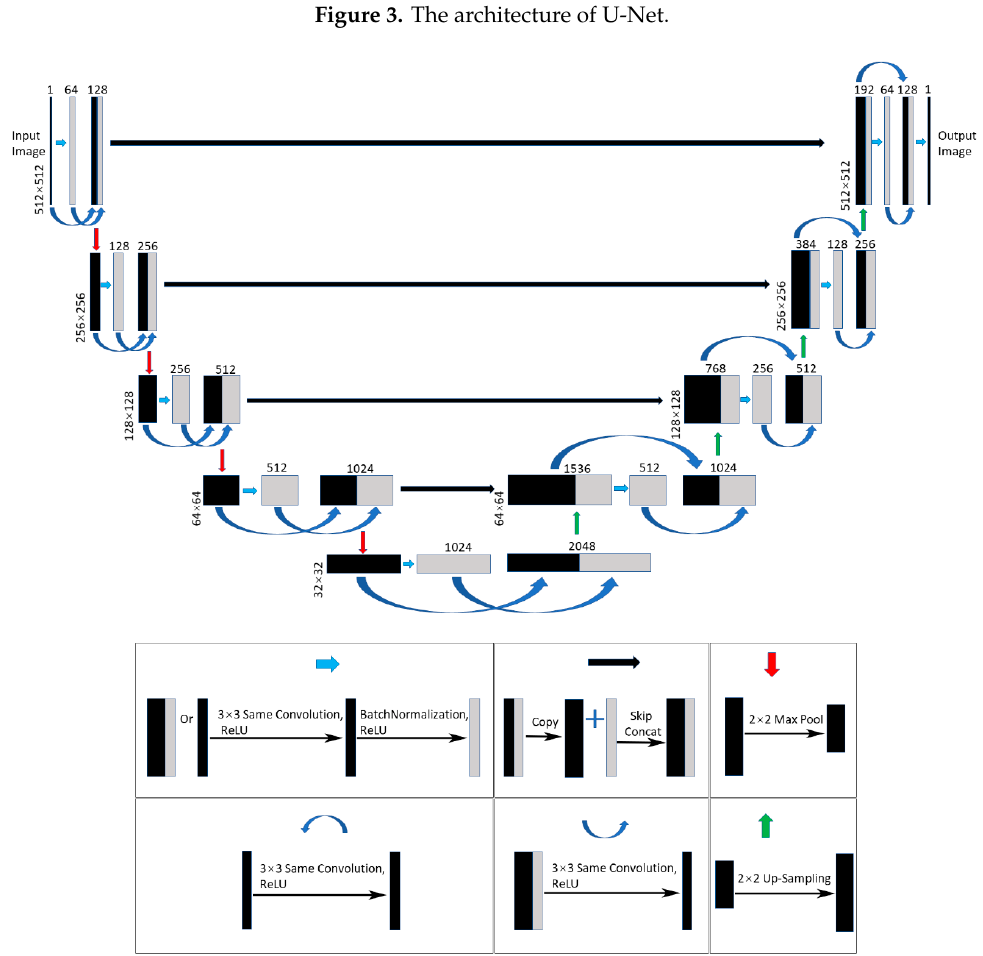
Figure 4. The architecture of Dense-U-Net. Its improvements to U-Net are that there are some densely connected parts in Den-U-Net. The resulting feature layer generated by the same convolution with a 3 × 3 kernel size and the BatchNormalization operation is concatenated with the feature layer generated by the same convolution with a 3 × 3 kernel size.